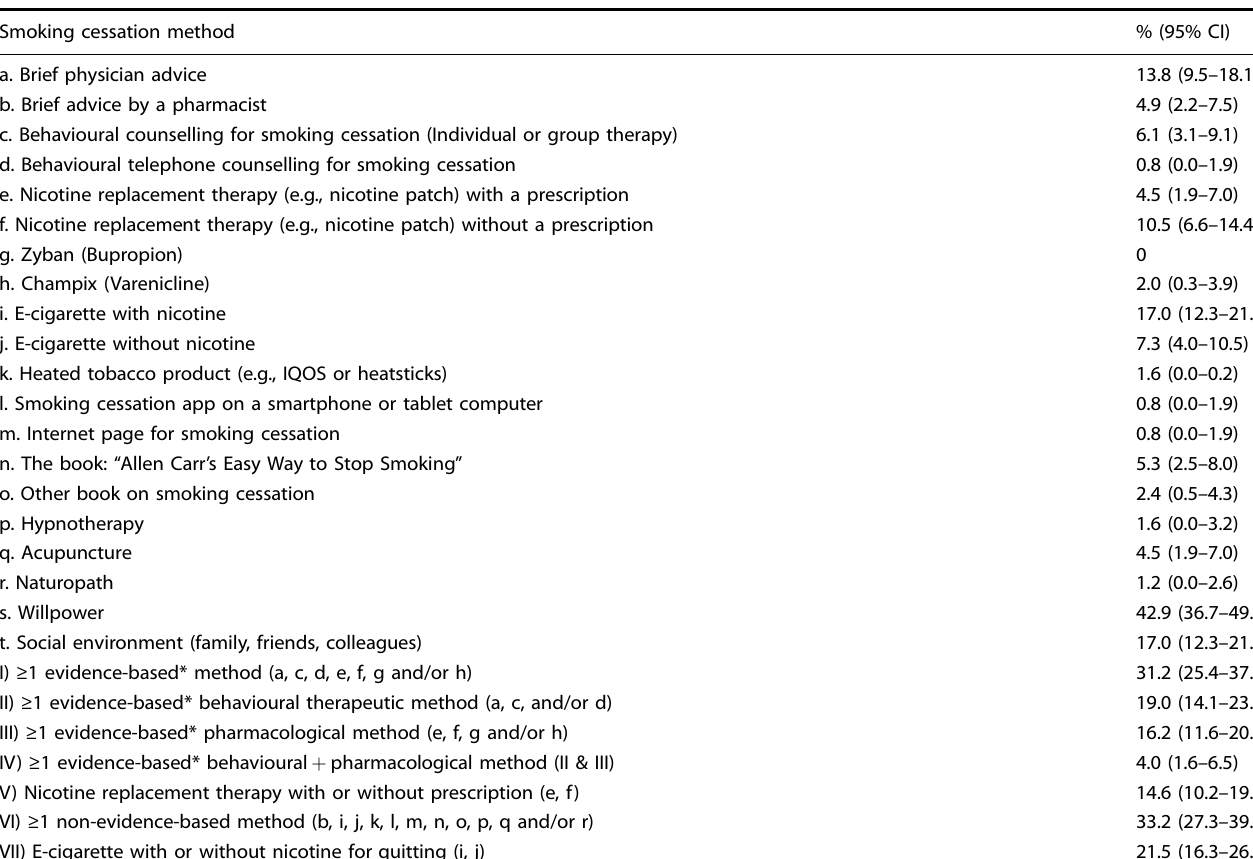
Table 3. Prevalence of the use of evidence-based smoking cessation methods and alternative methods (multiple answers allowed) during the most recent quit attempt among past-year smokers with COPD (FEV1/FVC <0.7) who reported ≥ 1 past-year quit attempt ( n =